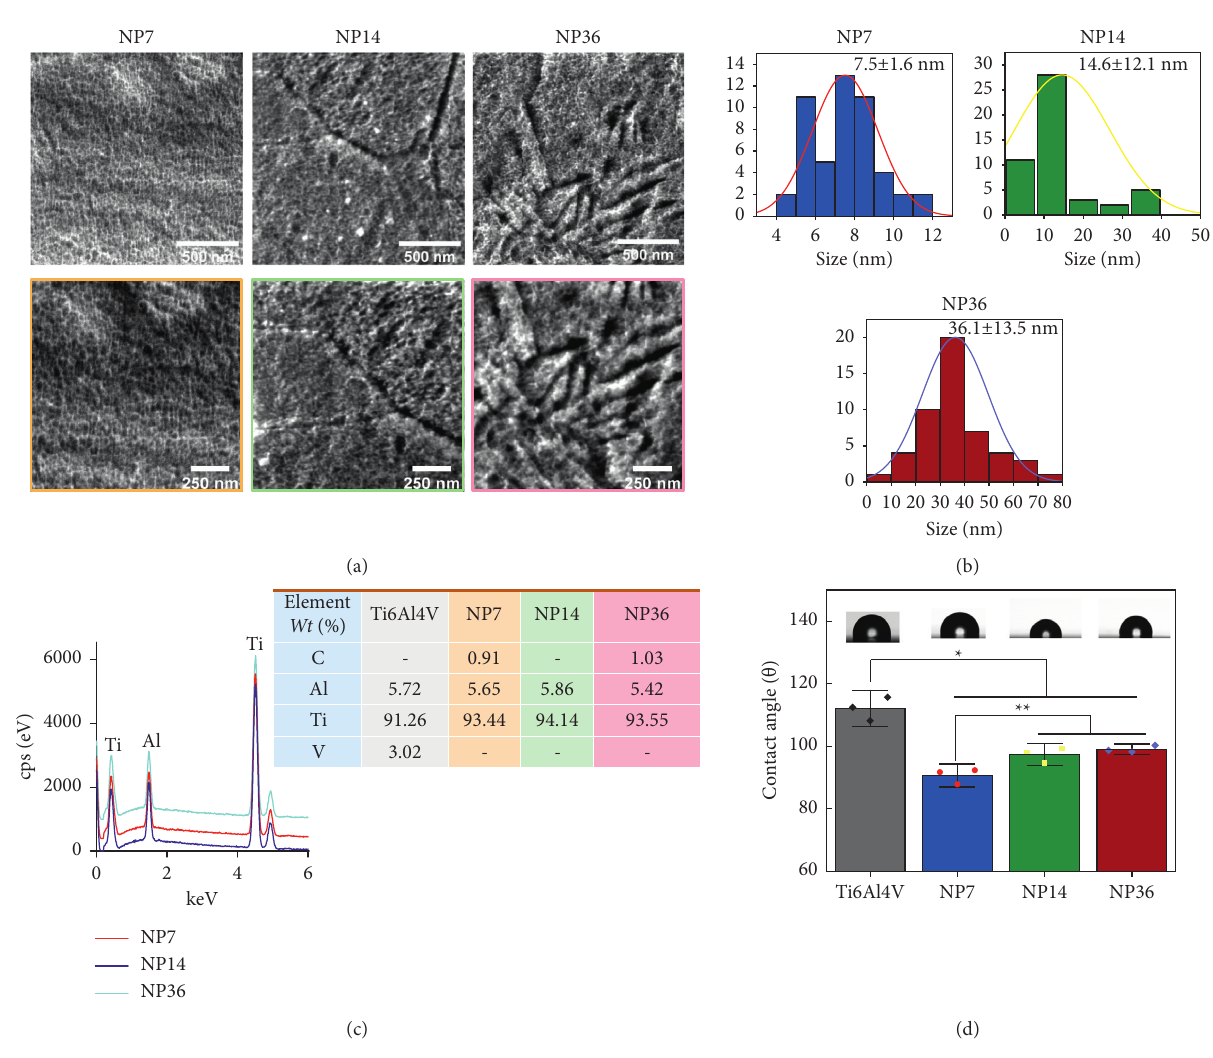
Figure 1: (a) FE-SEM of the synthesized materials. (b) Diameter distribution of the NPs. (c) EDX of the surfaces. (d) WCA of the specimens. The symbols ∗ and ∗∗ show significant differences between the